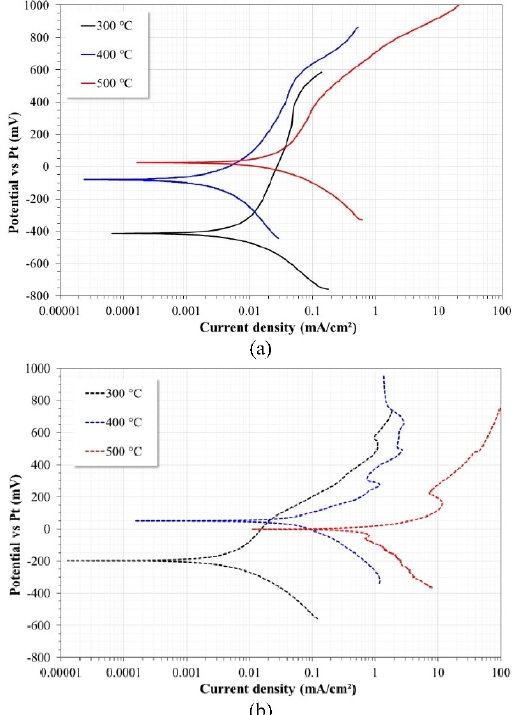
Figure 10. Potentiodynamic polarization curves of the Ni20Cr alloy immersed in: ( a ) Solar Salt and ( b ) ternary salt. Table 1. Electrochemical parameters of Ni20Cr alloy immersed in Solar Salt at different tempera- tures. Temperature Ecorr